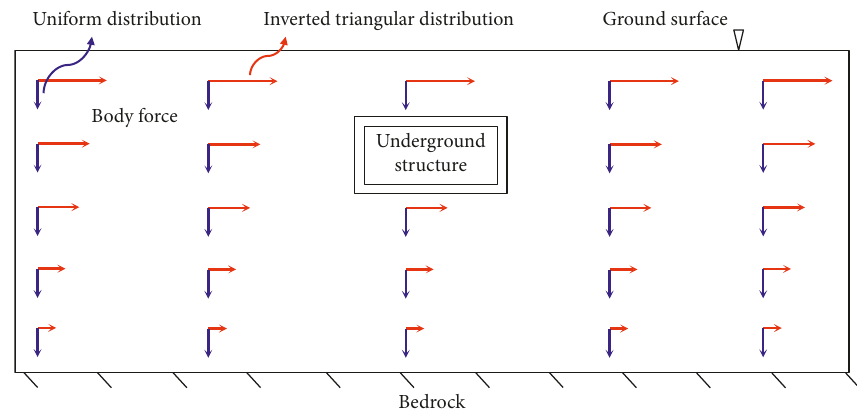
Figure 2: The computational model of pushover analysis.